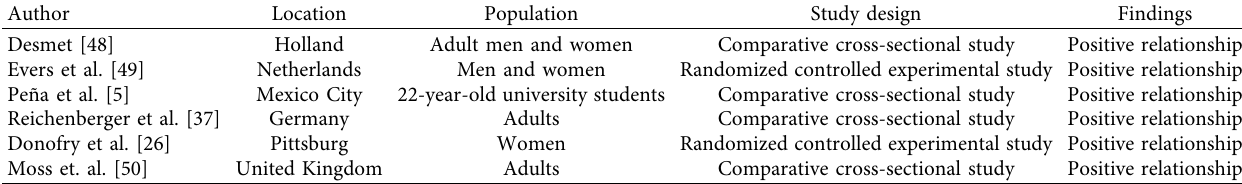
Table 4: Studies that report a relationship between positive emotions and hyperpalatable energy-dense food intake in adults. Author